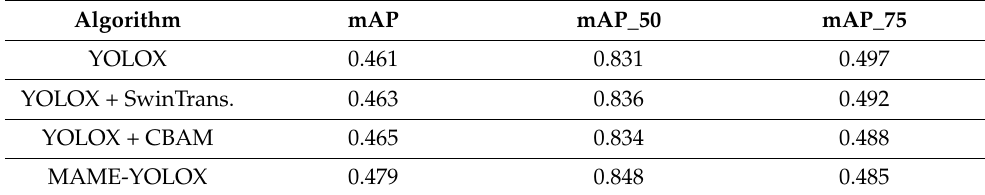
Table 8. The ablation experiments on the AIBD dataset.